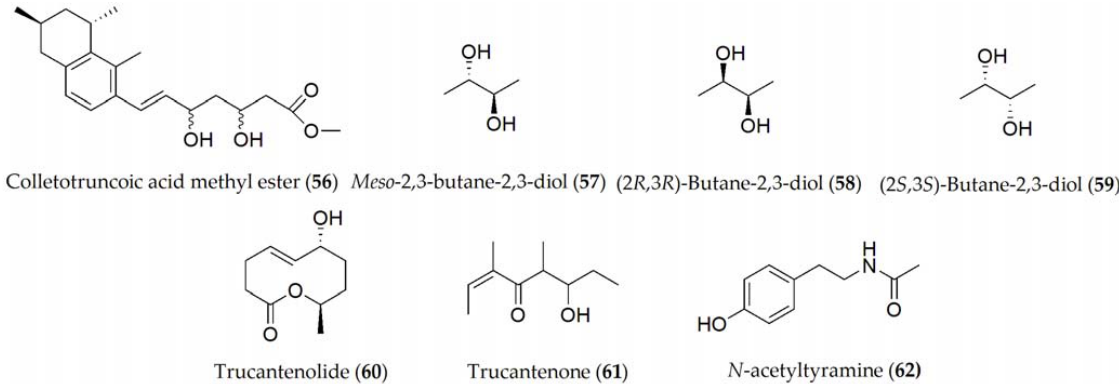
Figure 9. Phytotoxins isolated from Colletotrichum truncatum . Truncatenolide ( 60 ) showed the strongest phytotoxic activity when tested on soybean seeds while tyrosol and N ‐ acetyltyramine ( 9 and 62 ) exhibited phytotoxicity to a lesser extent. Furthermore, truncatenone ( 61 ) weakly stimulated the growth of the seed root in and C. nicotianae , truncatenolide ( 60 ) showed significant antifungal activity against M. phaseolina and the total inhibition of C. nicotianae . Thus, some other fungal nonenolides